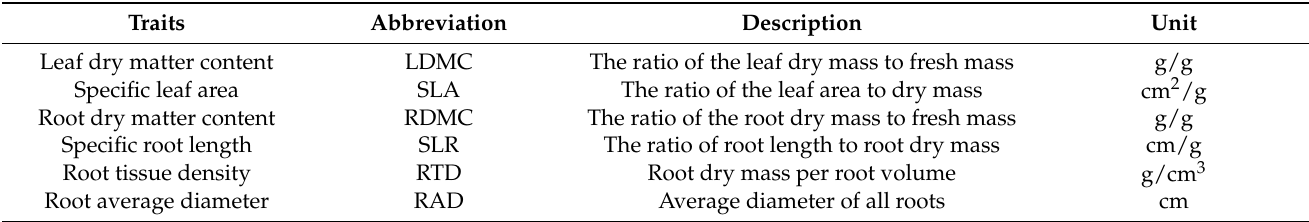
Table 1. Functional traits measured in this